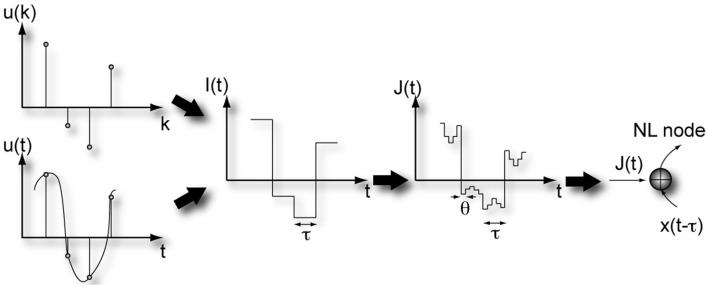
Illustration of the masking steps required for information processing in a delay-based reservoir computer. Figure has been adapted from Appeltant et al. (2011).